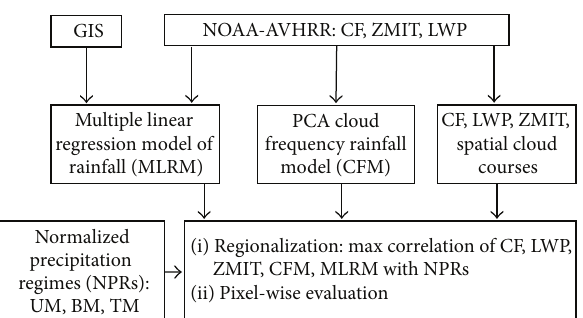
Figure 2: Overall work flow of spatial data set generation of